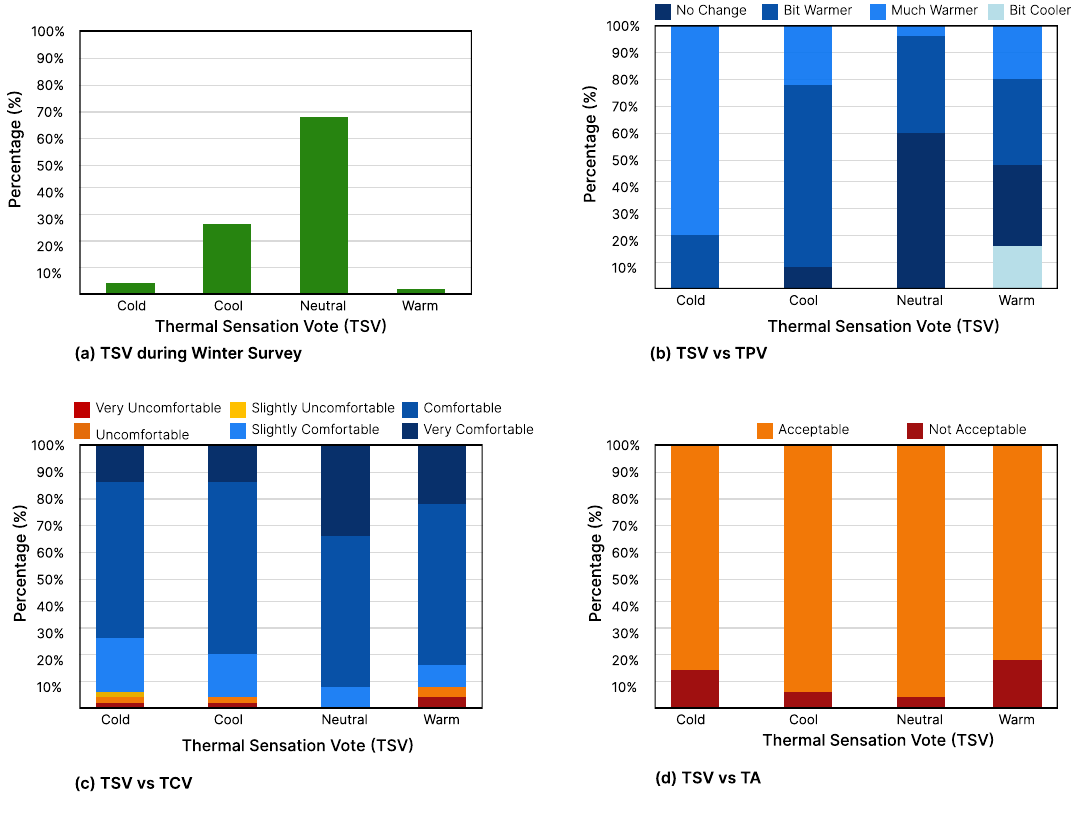
Figure 2. Thermal Sensation Vote vs TPV, TCV and TA for Winter